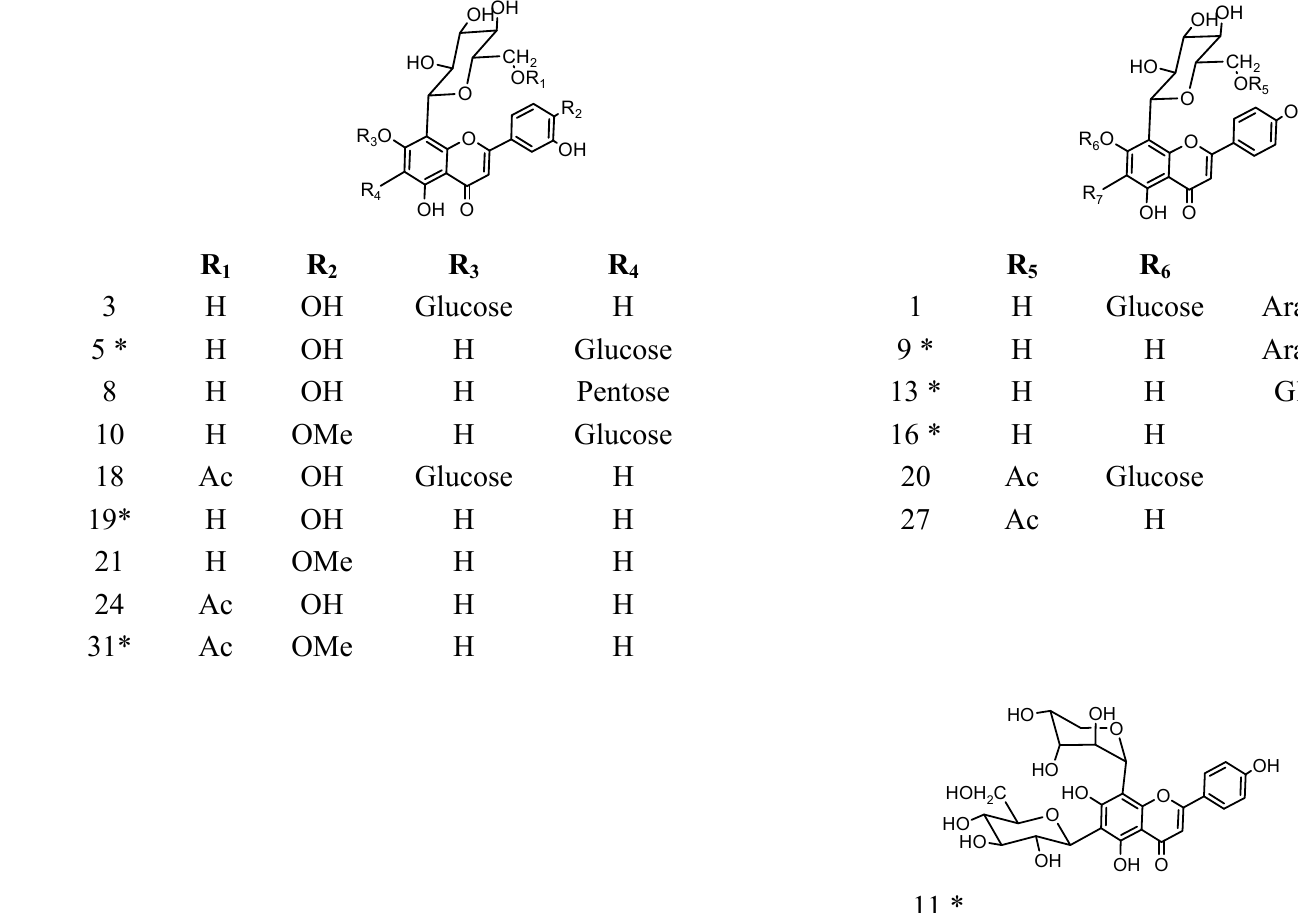
* Identified by co-elution with standard